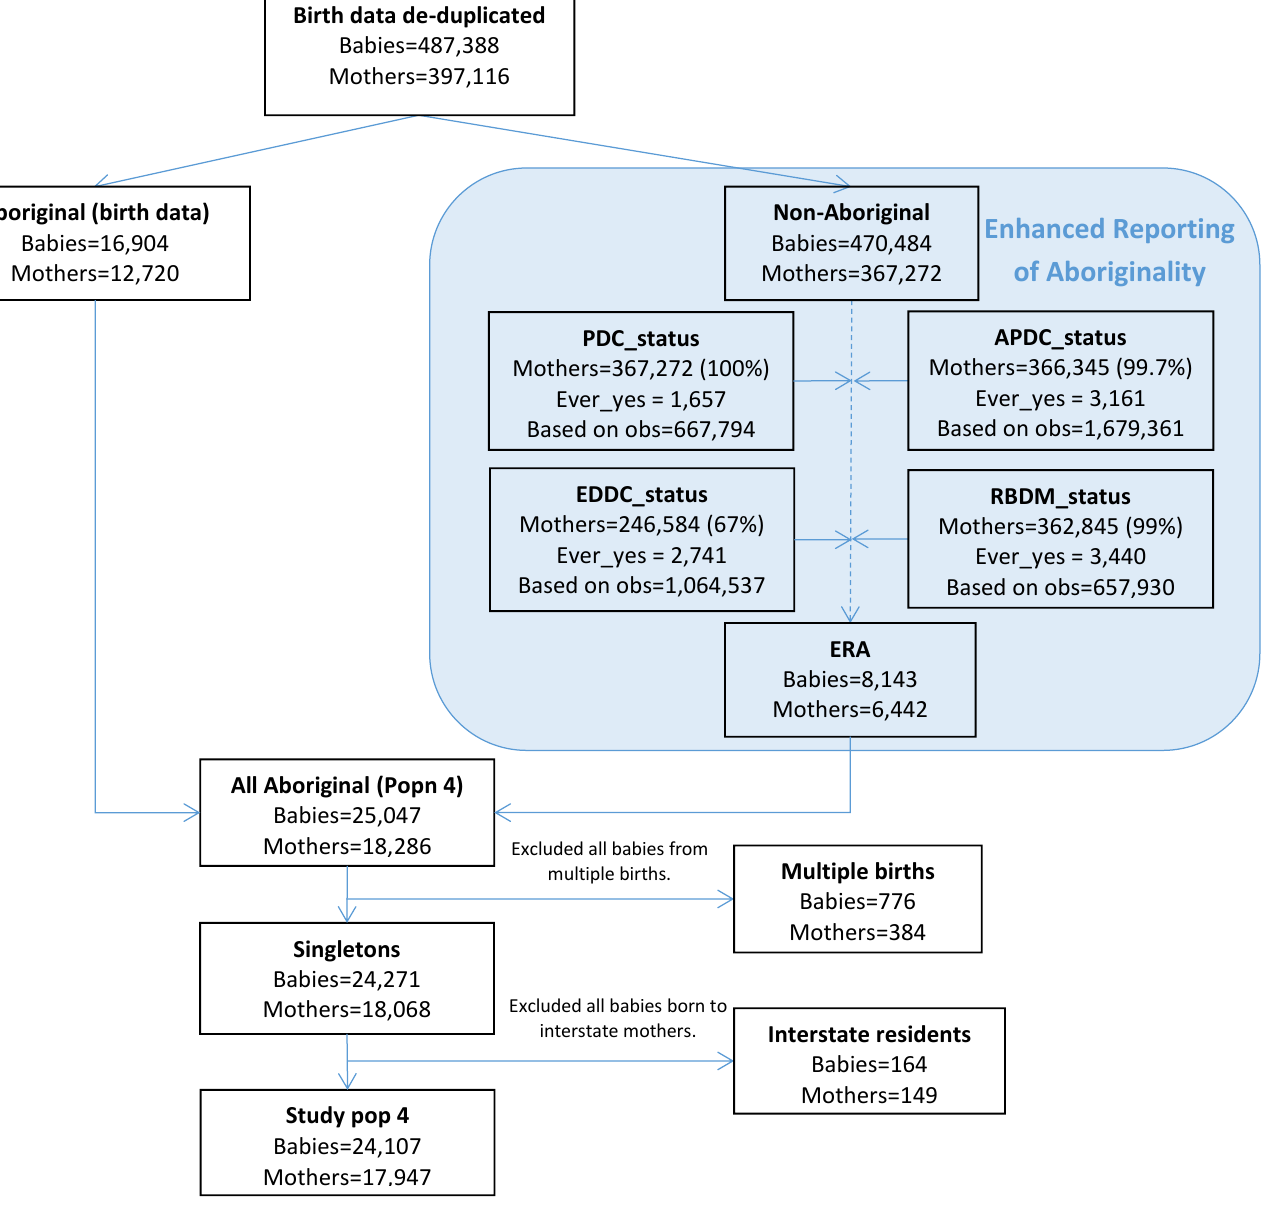
Figure 6: Flow diagram of mothers and babies eligible for inclusion in study population 4. Aboriginality of mothers in this study population was based on ever being recorded as Aboriginal in any of the available linked data.